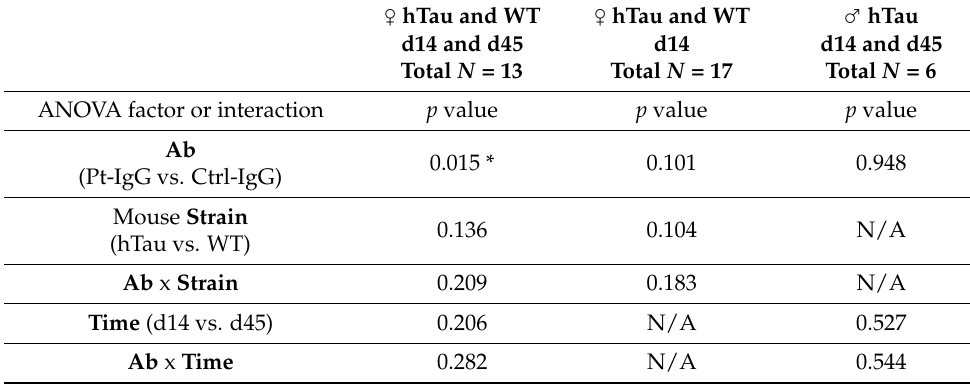
Table A11. Statistical analysis of inter-lick interval during